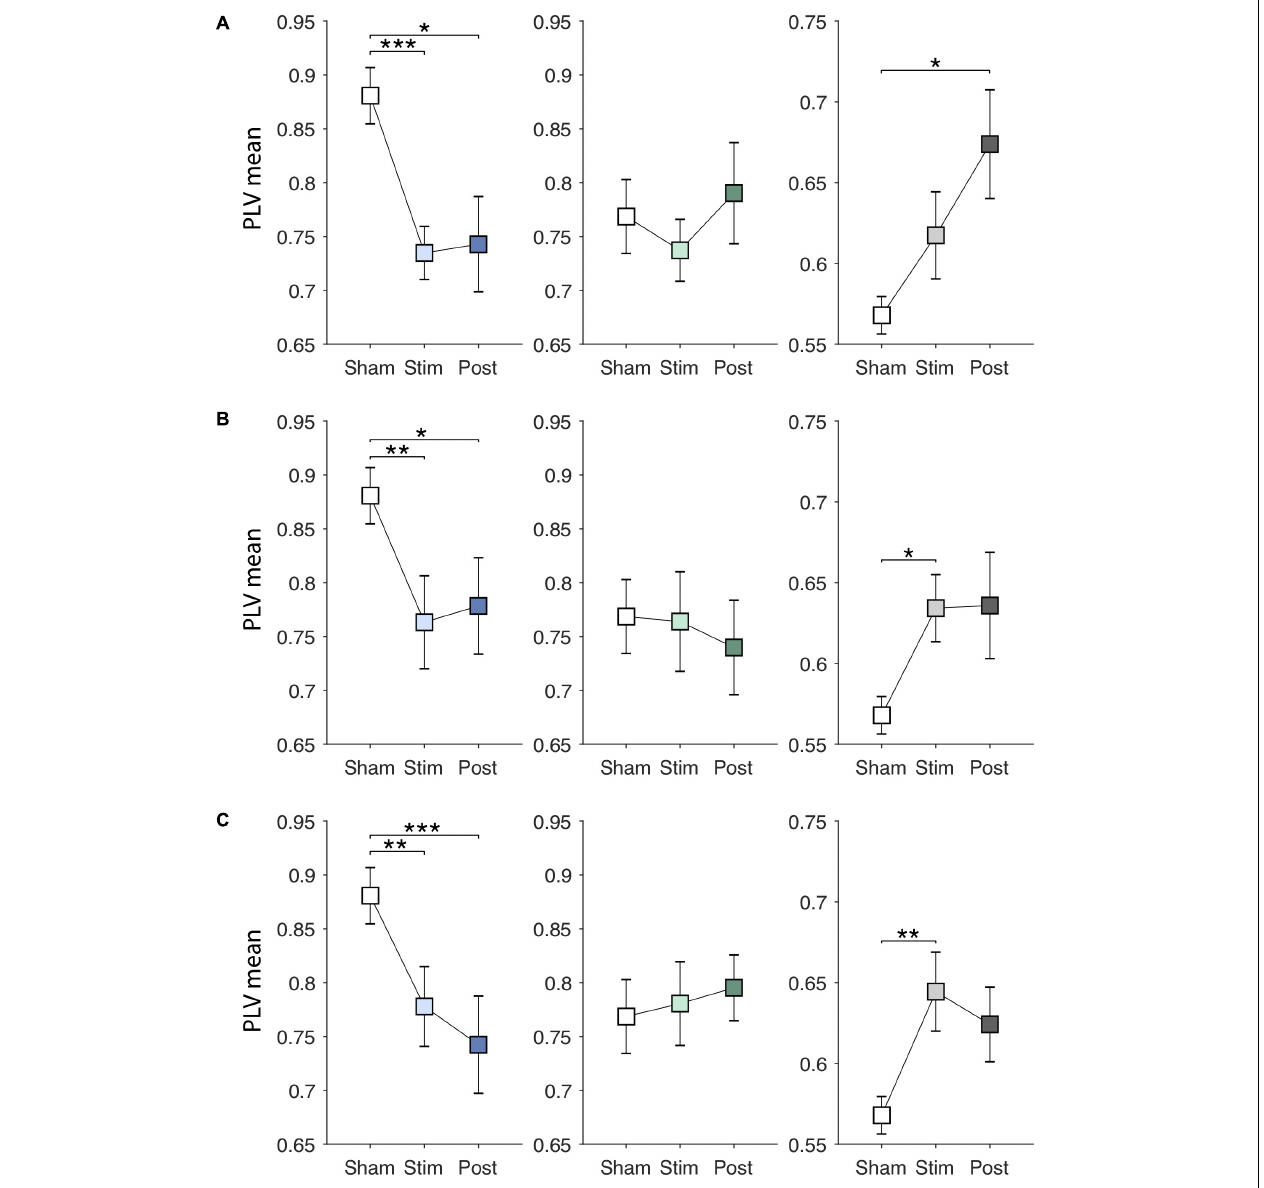
FIGURE 4 | Effects of EVS on the PLV mean. The PLV mean values in the sham condition are identical to those in Figure 3A . The PLV mean values in the stimulation (60 s) and post-stimulation period (20 s) were obtained in the same manner by multiplying the discriminant vector to the corresponding data sets. In each row, from the left, the results for the PDMOFF (blue), PDMON (green), and HC (gray) groups are presented in each panel. Significant P -values from repeated measures ANOVA with post hoc Tukey’s HSD test are indicated ( ∗ P < 0.05; ∗∗ P < 0.01; ∗∗∗ P < 0.001). (A) EVS1 effects. (B) EVS2 effects. (C) EVS3 effects.